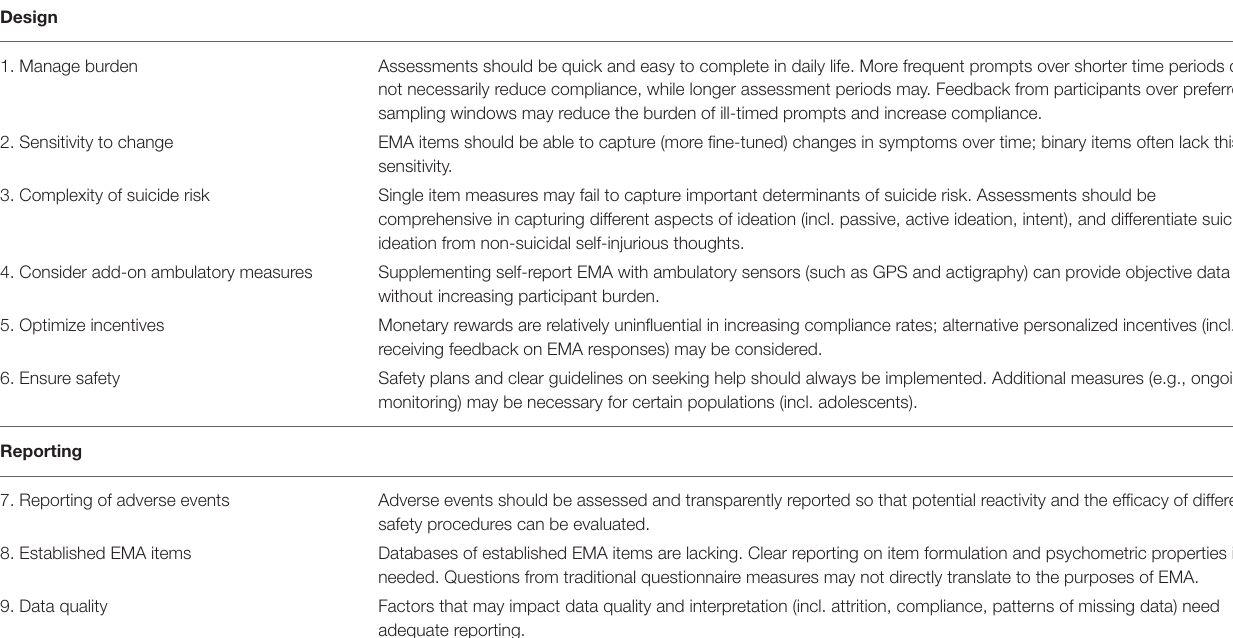
TABLE 3 | Considerations for designing and reporting EMA studies in suicide research.